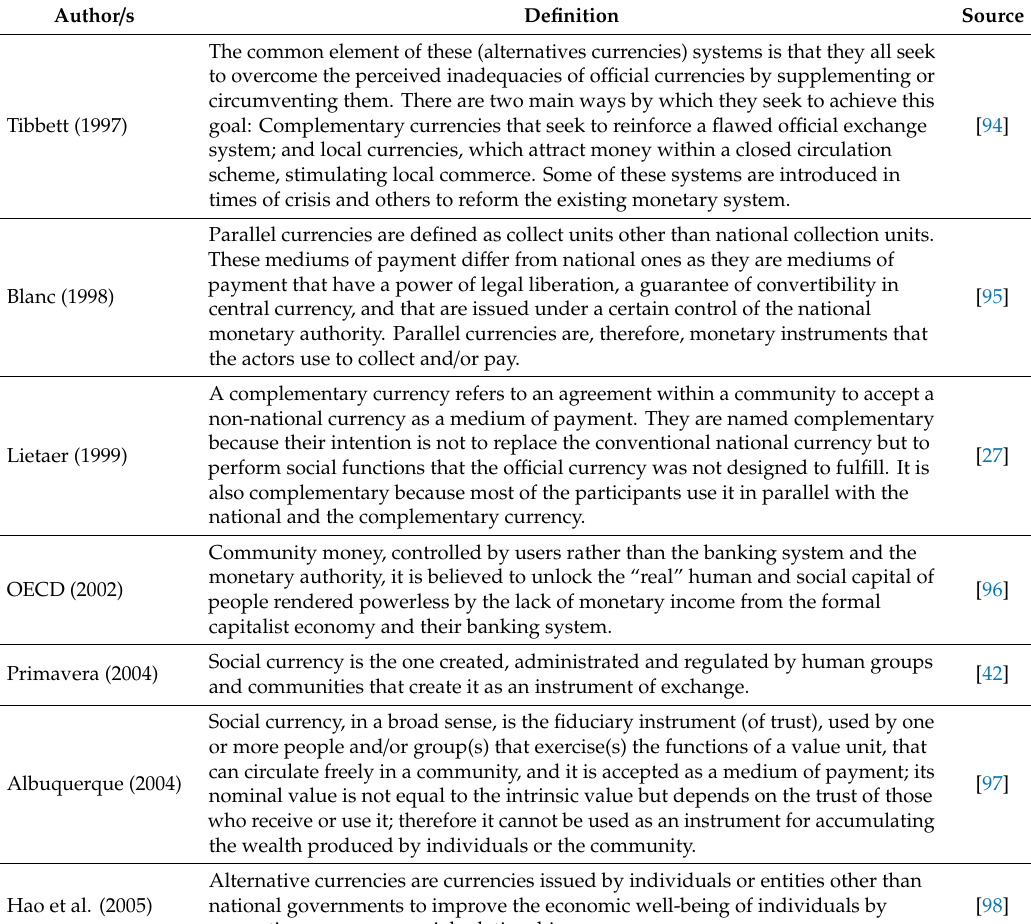
Table A1. Main complementary monetary systems